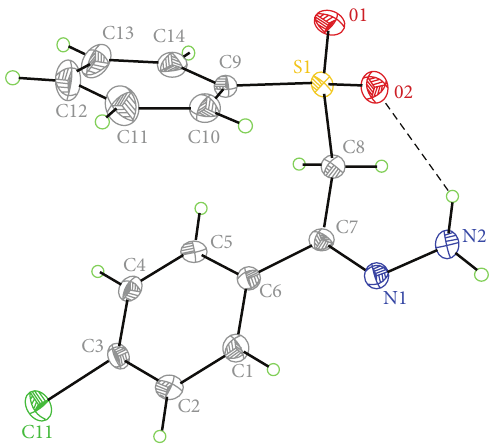
Figure 1: ORTEP diagram of 5a , 40% probability ellipsoid, showing intramolecular hydrogen bond N2–H1 ⋅ ⋅ ⋅ O2 (dashed line).